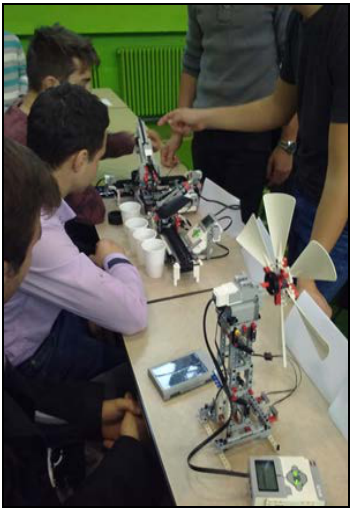
Figure 4: The students of Turda Technical College participate in a project competition with a Lego mini wind turbine Source: P hotograph by Daniela Alina Oprea, March